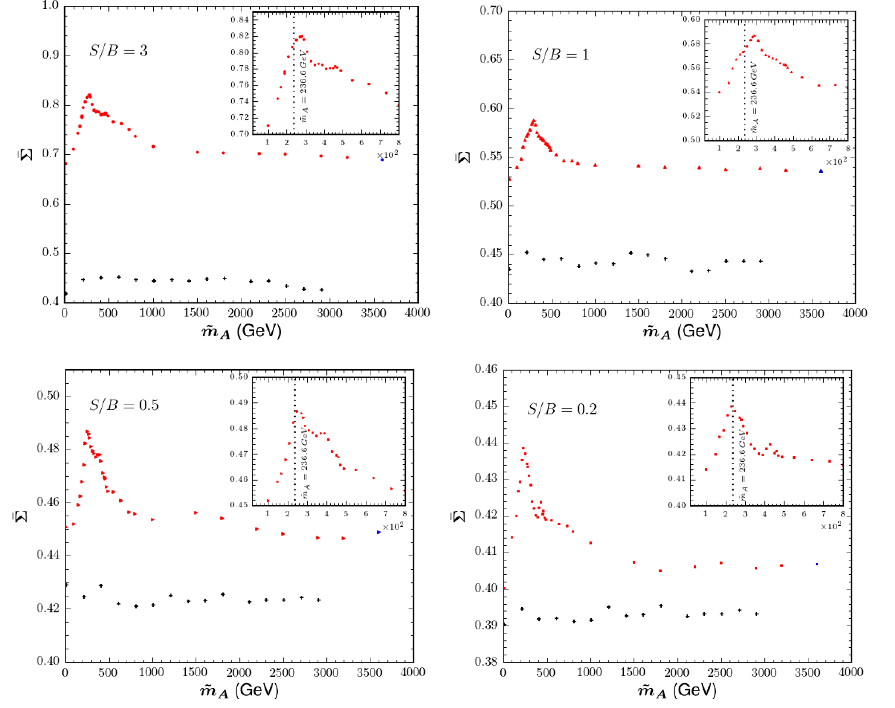
Figure 11 . The quantity (cid:22)(cid:6)( ~ m A ) de(cid:12)ned in (3.9) as a function of ~ m A for di(cid:11)erent values of the signal to background ratio S=B de(cid:12)ned in (3.10): S=B = 3 (upper left panel), S=B = 1 (upper right panel), S=B = 0 : 5 (lower left panel) and S=B = 0 : 2 (lower right panel). The colored symbols correspond to the true branch with the color conventions from (cid:12)gure 2, while the black crosses indicate points on the auxiliary branch. The insert on each panel zooms in on the region near the peak value for (cid:22)(cid:6)( ~ m A